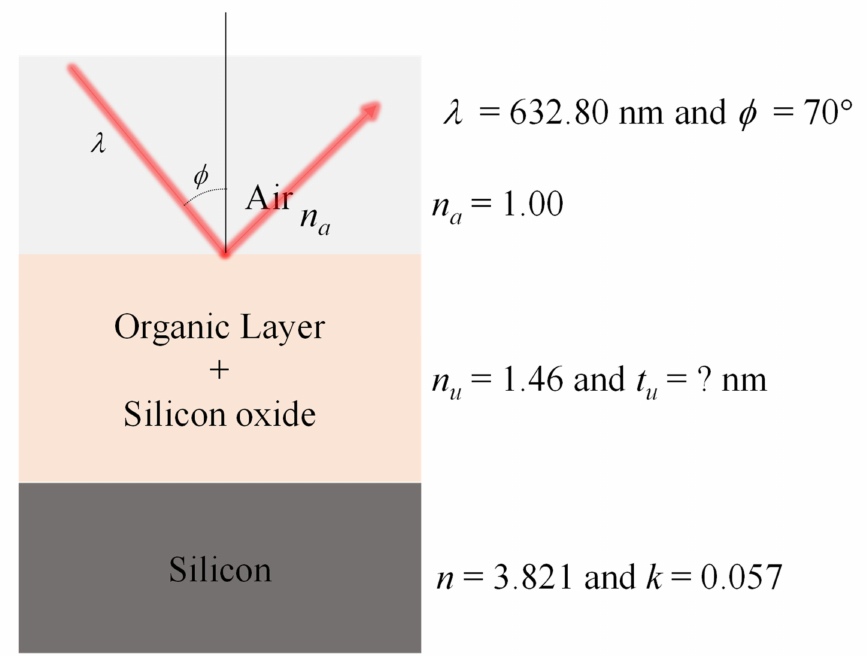
Figure A6. Model of the three layers used for the analysis of the ellipsometric results. Right side notations and numbers are dielectric constants were used to obtain ellipsometry thickness (tu). Whereas n a = ambient air, n u = upper organic layer + silicon oxide layer, t u = thickness of upper organic layer + silicon oxide layer, and n = refractive index of silicon, k = extinction coefficient of silicon. In addition, plasma cleaned unmodified silicon oxide layer on silicon was measured 672 ± 0.2